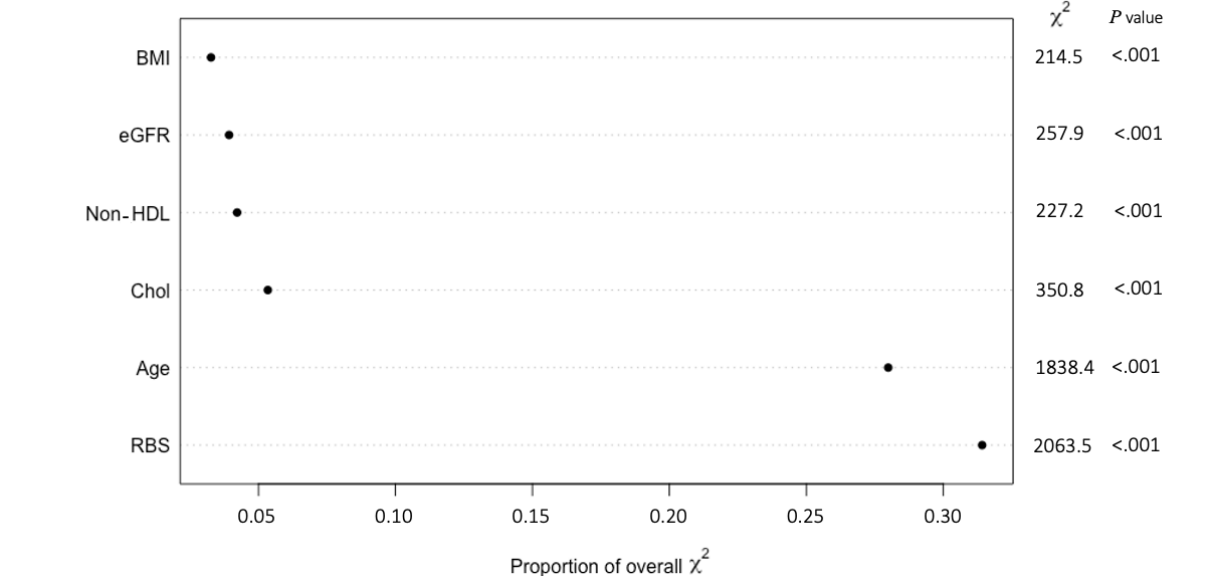
Figure 4. Order of importance of predictors for PM1. Chol: cholesterol. eGFR: estimated glomerular filtration rate. HDL: high-density lipoproteins. PM: predictive model. RBS: random blood sugar.